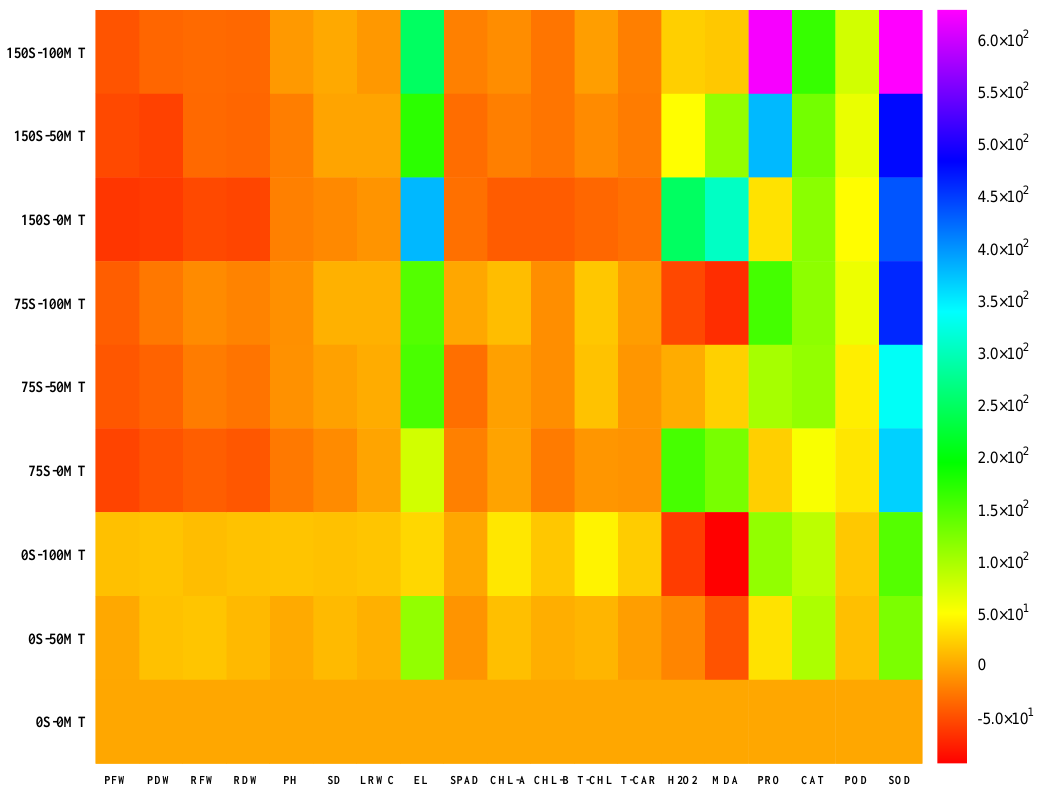
PF W P D W R F W RD W P H